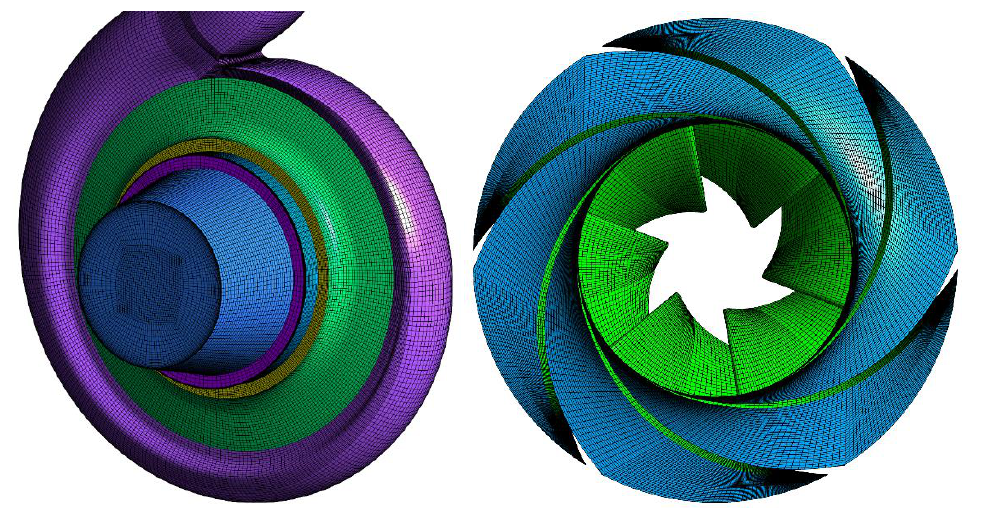
Figure 1. 3D model of the flow passages.